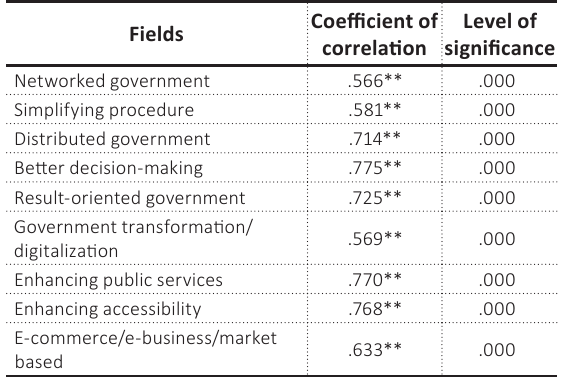
Table 4. Pearson correlation test for e-government